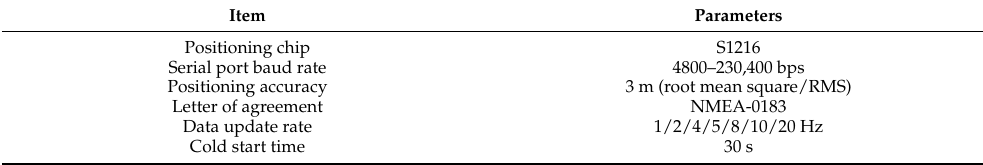
Table 1. Parameters of